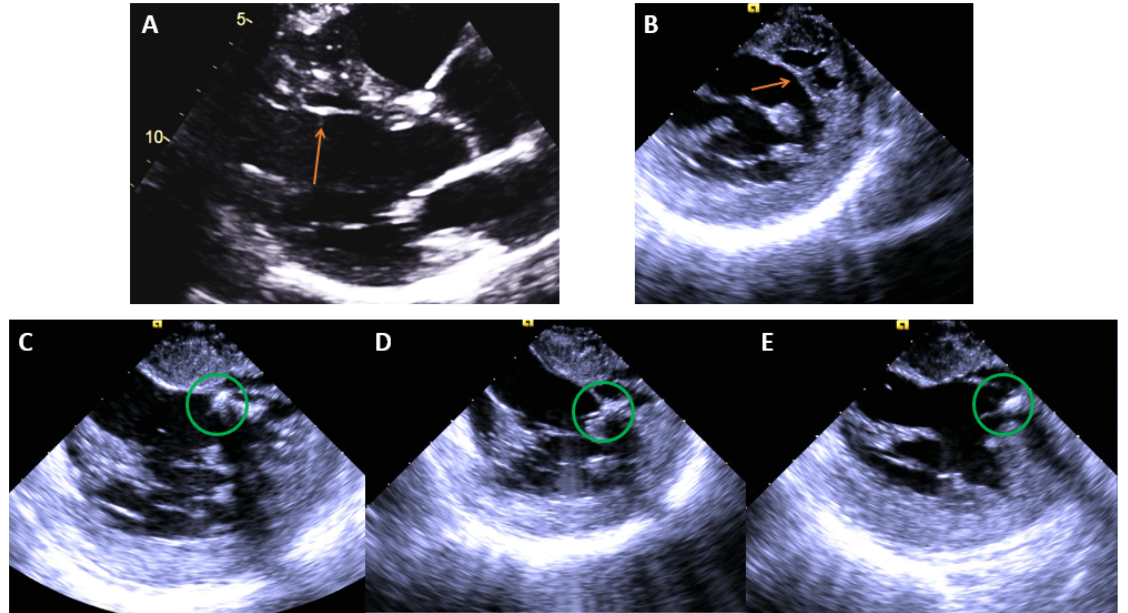
Figure 12. ( A ) Echo image showing a false tendon (orange arrow) on the anteroseptum of the LV, ( B ) ICE image showing the same structure. ( C – E ), ICE images of cryoablation on the false tendon with ablation lesions spanning the proximal, mid, and distal segments moving left to right noted by the green circles (Table